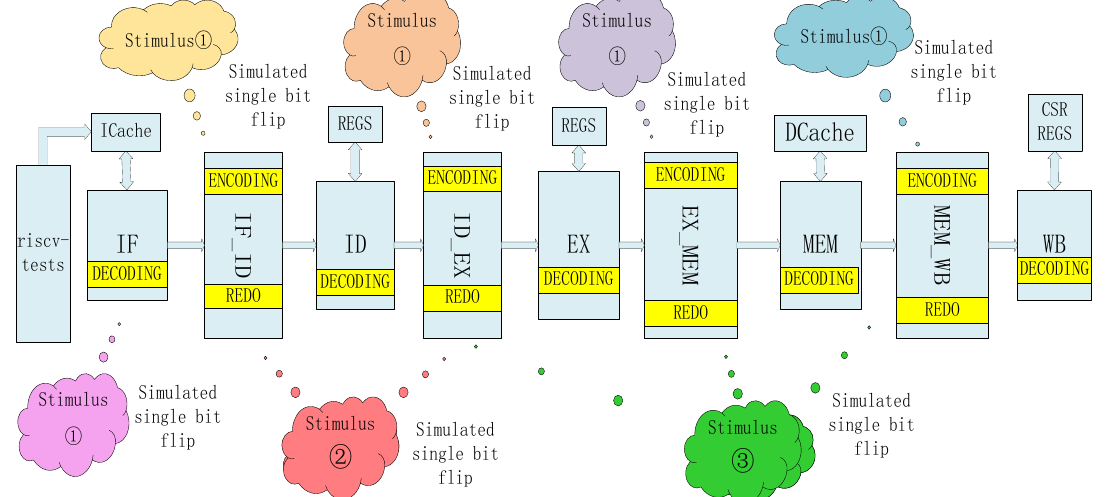
Figure 22. Simulation test excitation diagram.